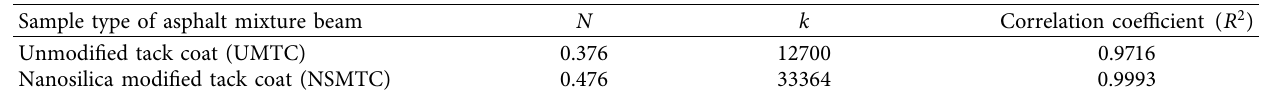
Table 6: Values of n , k , and correlation coefficients for fatigue life prediction